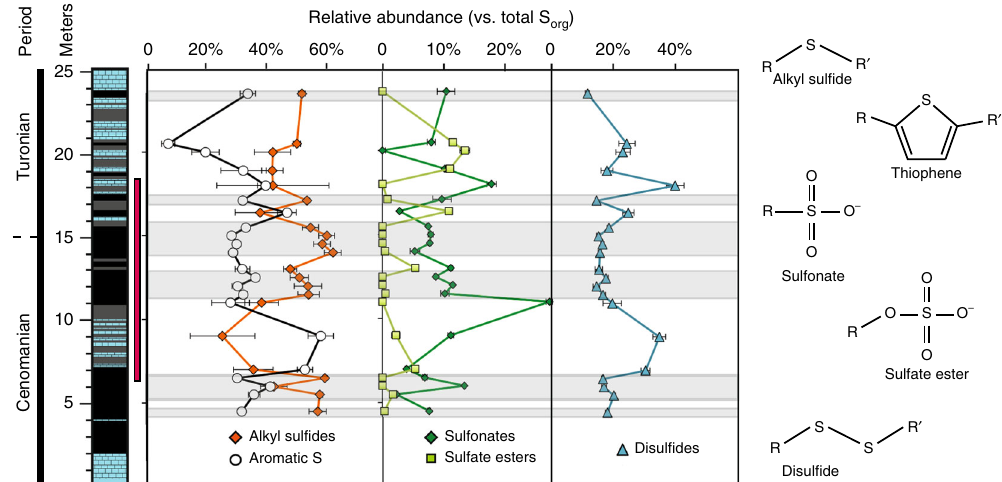
Fig. 2 Relative abundance of organic sulfur in various redox states with depth. The red bar at left indicates the duration of the OAE2 C-isotope excursion, and shaded bands indicate intervals with TOC concentrations >1 wt%. Error bars represent uncertainties from spectrum fi tting via SIXPACK (1 s.d., Supplementary Table 2). Low-TOC rocks tend to be richer in aromatic S (open circles) while high-TOC rocks contain substantial amounts of alkyl sul fi des (orange diamonds). Representative S org structures are shown on the right